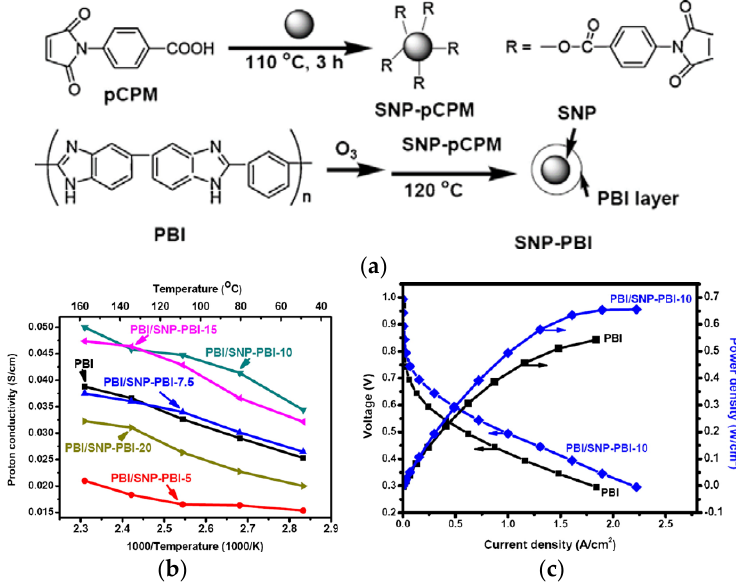
Figure 12. Ozone-mediated process for the synthesis of PBI/SNP–PBI nanocomposite membranes ( a ); proton conductivity of PBI/SNP–PBI membranes with different filler content ( b ); PEMFC polarization curve of PBI compared to PBI/SNP–PBI with 10 wt.% SiO 2 membranes at 150 °C using dry H 2 /O 2 as reactant at a flow rate of 0.3 L/min ( c ). Reprinted with permission from Ref. [112]. Copyright 2012 Elsevier.